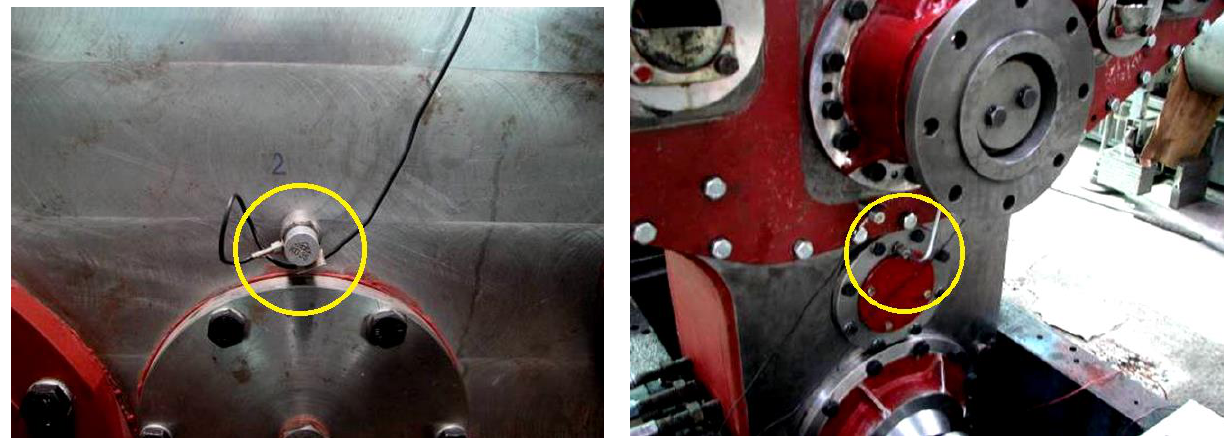
Figure 19. Acceleration transducer mounted at point No. 2 and 3 measures. Accelerometers are highlight with a yellow circle.